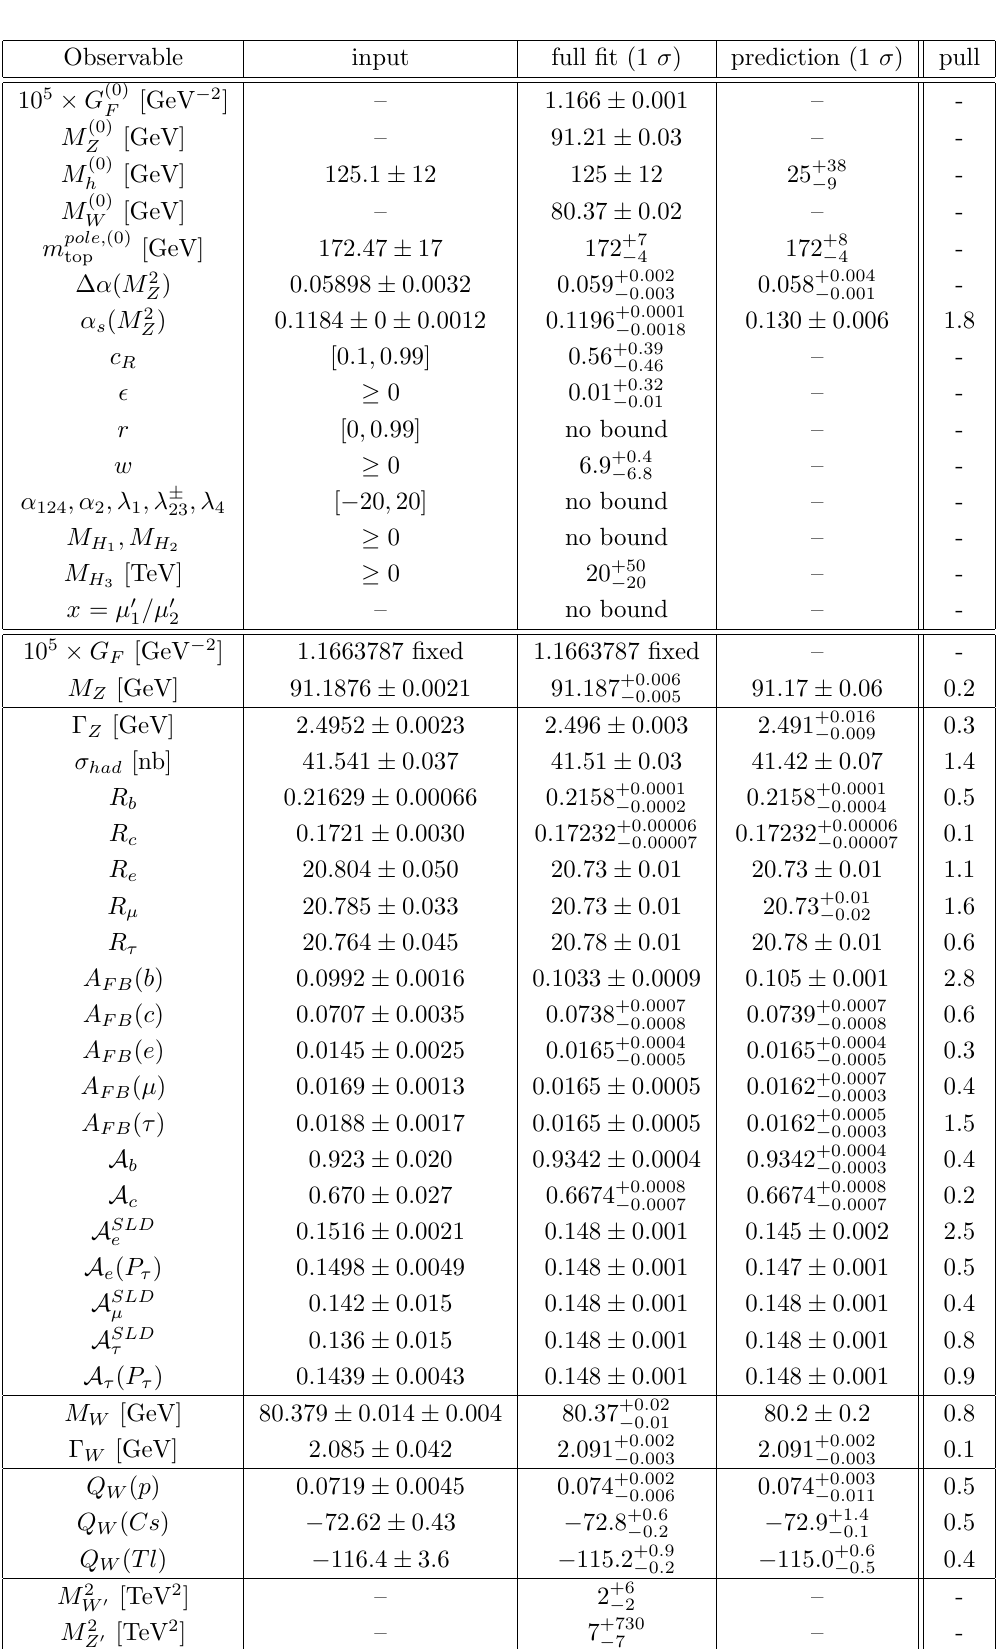
Table 2 . Same as in the table 1 but in the DLRM except for m pole; (0) increased the error bars of the input value, see the discussion of the results in section